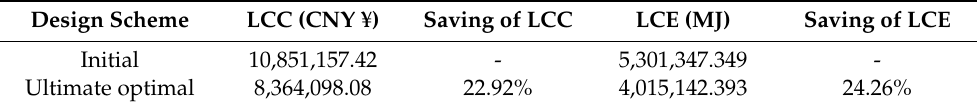
Table 5. Performances of the initial design and the ultimate optimal design.